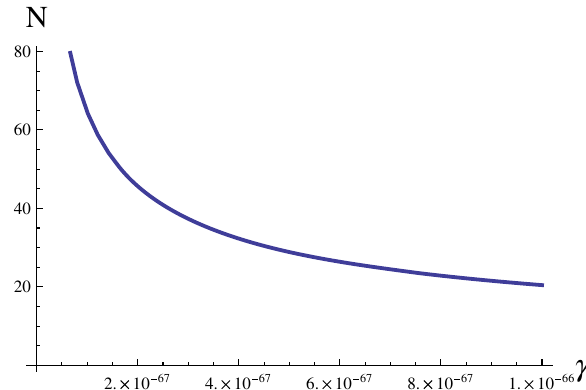
Fig. 1 Illustration of the dependence ¯ ρ (cid:17) of (cid:17) . We assume that γ = Fig. 3 The diagram of the relation between γ and the approximate . Note that this 1 . 16 × 10 − 69 s 2 . ¯ ρ (cid:17) is expressed in units of km 2 s 2 Mpc 2 number of e-foldings N = ¯ H init ( ¯ t fin − ¯ t init ) from ¯ t init to ¯ t fin . We assume potential has the same shape like the Starobinsky potential that ¯ t fin − ¯ t init ≈ 10 − 32 s. The parameter γ is expressed in units of s 2 . Note that the number of e-foldings grows when the parameter γ decreases and N = 60 when γ = 1 . 16 × 10 − 69 s 2